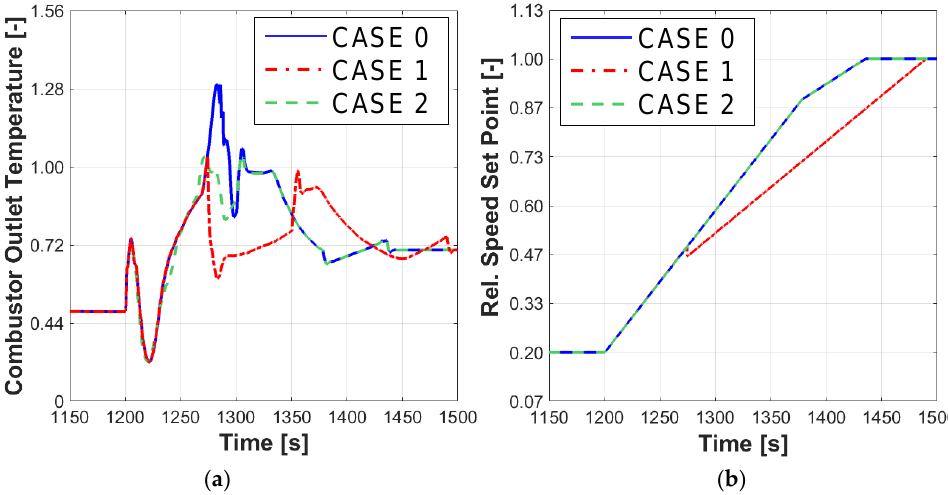
Figure 8. Start-up simulation up to Grid Synchronization. Left: Combustor temperature normalised with respect to the maximum temperature allowed. Right: Normalised speed set point.